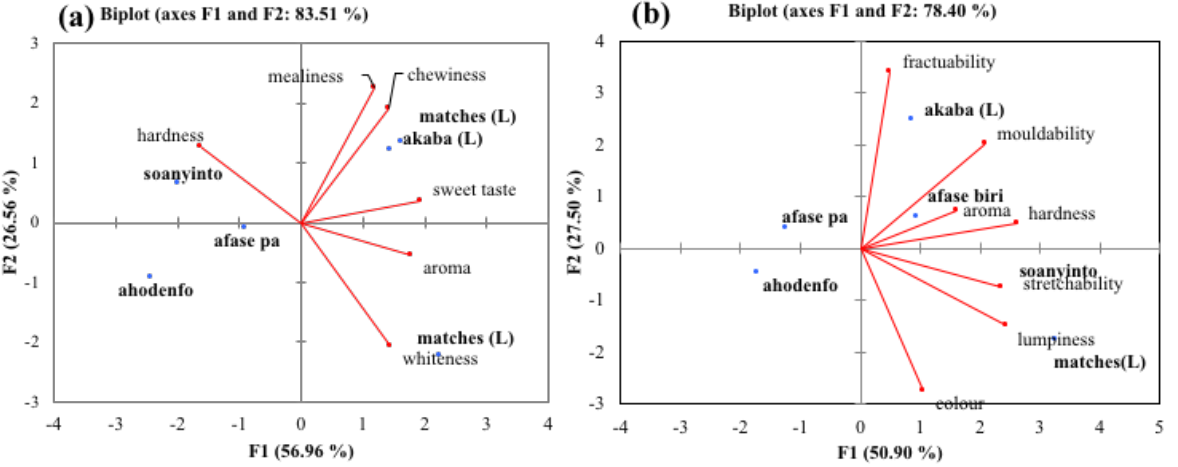
Figure 1. Principal component of descriptors of quality for ( a ) boiled and ( b ) pounded D. rotundata varieties. Yam varieties: CRI pona, CRI kukrupa, CRI Mankrong pona, serwaa, local pona; L = local variety.